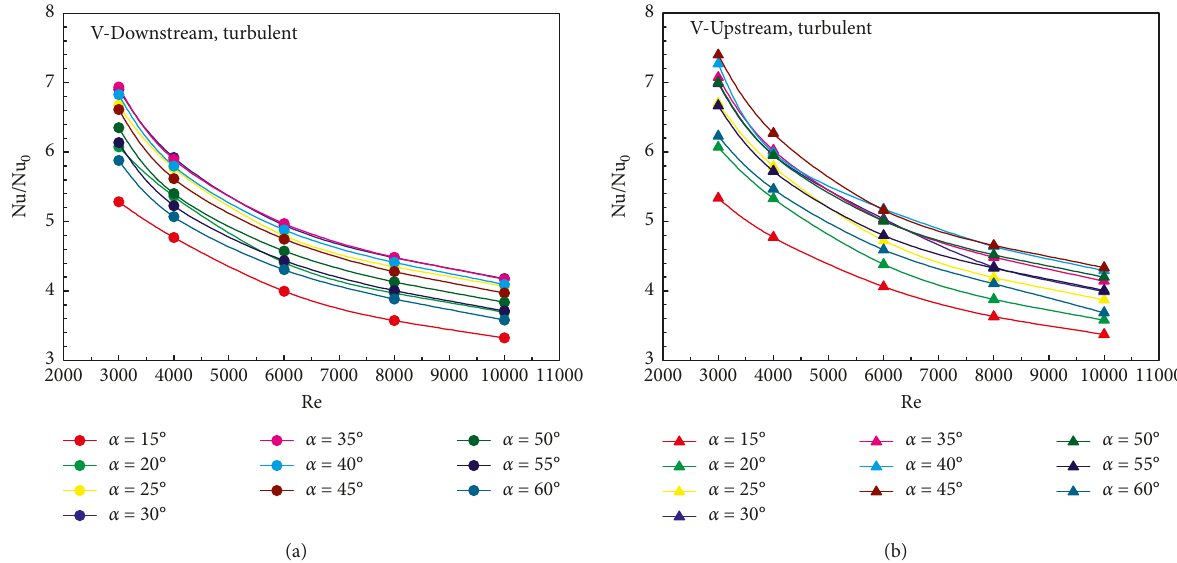
Figure 21: Relations of Nu/Nu 0 with Re for the heat exchanger tube inserted with the V-wavy surface for (a) V-Downstream and (b) V- Upstream at the turbulent